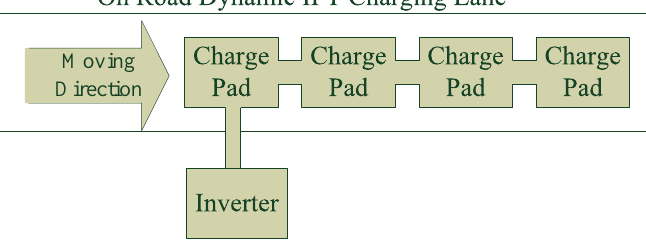
Figure 11. Illustration of the discrete IPT charging pads for on-road dynamic charging.